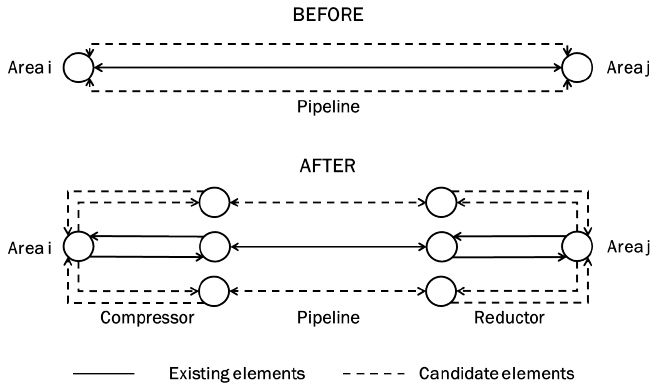
Figure 1. Natural gas transmission link